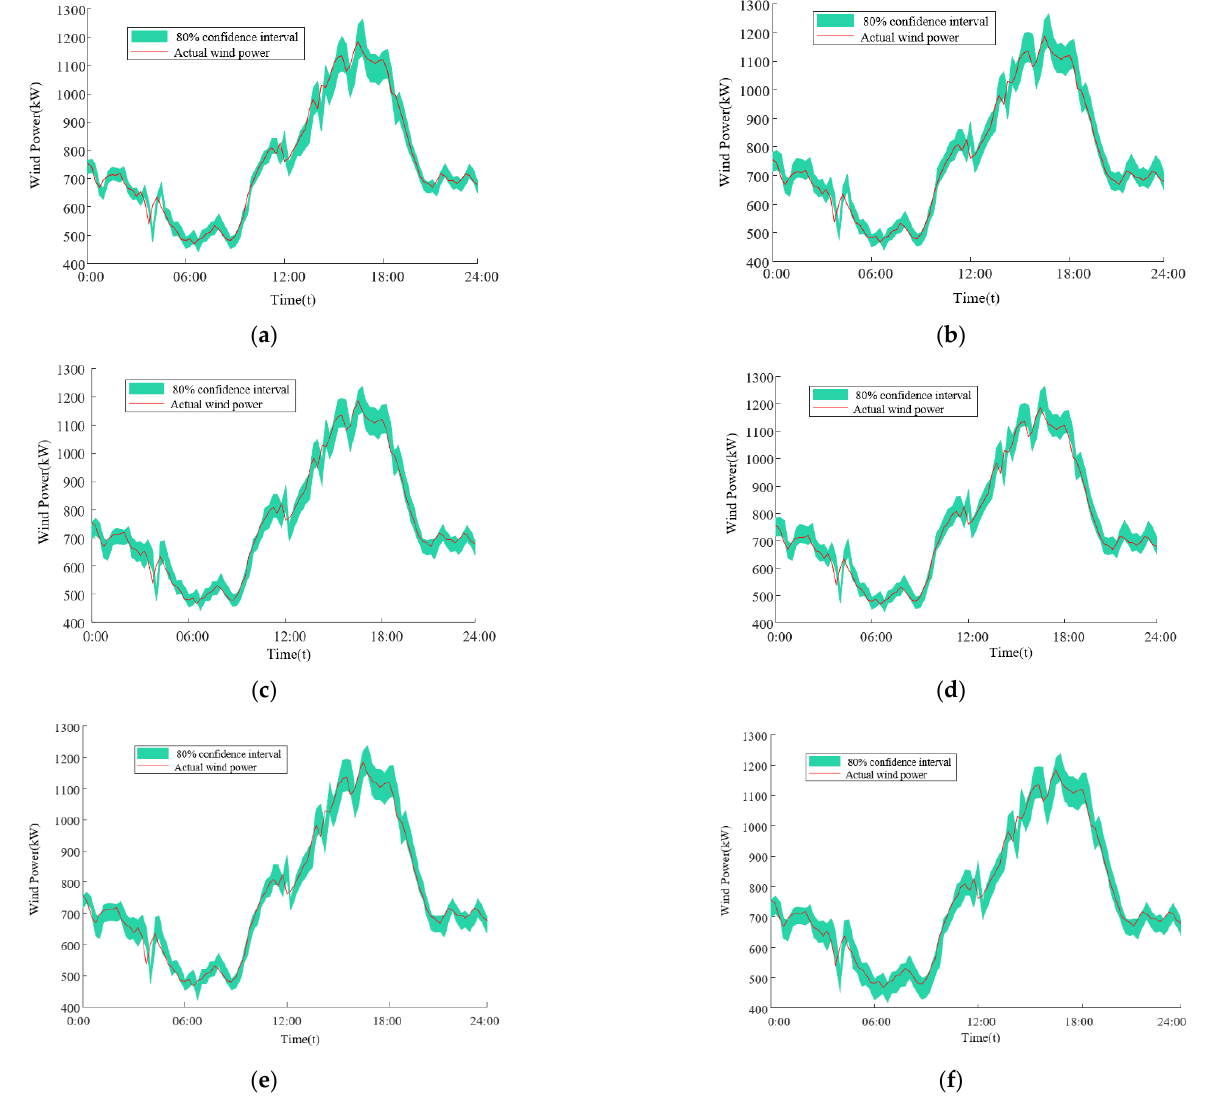
Figure 6. Prediction results of different models under 80% confidence interval: ( a ) BPNN; ( b ) LSTM; ( c ) BLS; ( d ) RBF; ( e ) KELM; ( f ) XGBoost.